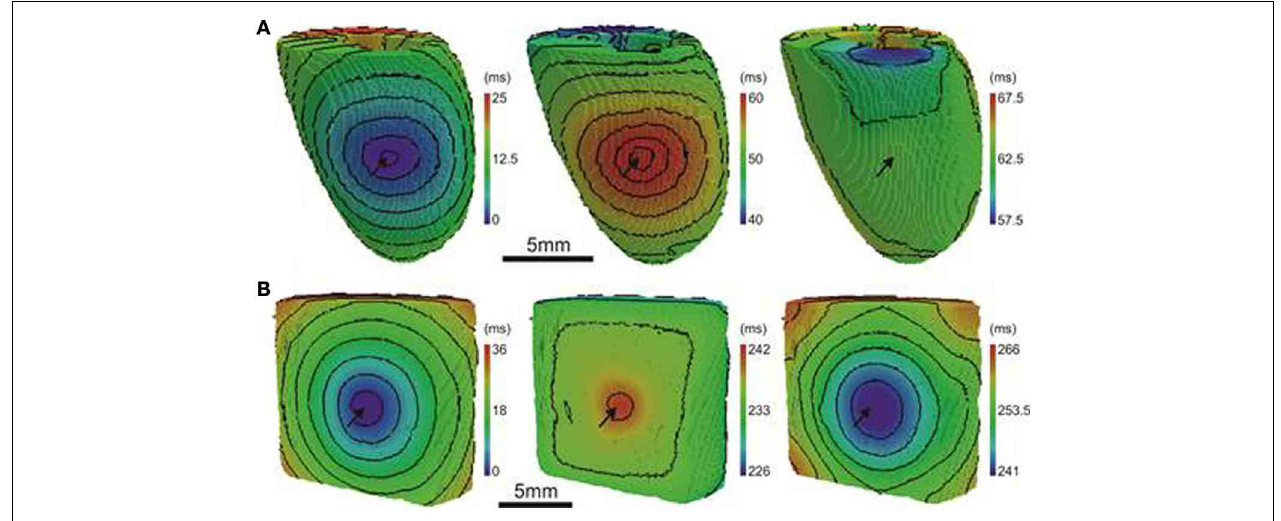
FIGURE 10 | AT, APD, and RT maps for isotropic simulations. In rat (A) and pig (B) simulations, the activation sequences (left panels) show no preferential direction of propagation. Sites of stimulation are indicated by arrows. The distribution of APD (middle panels) is tightly coupled to the activation sequence in rat simulations but to a much lesser extent in the pig. A decreasing trend of APD away from the pacing site was observed